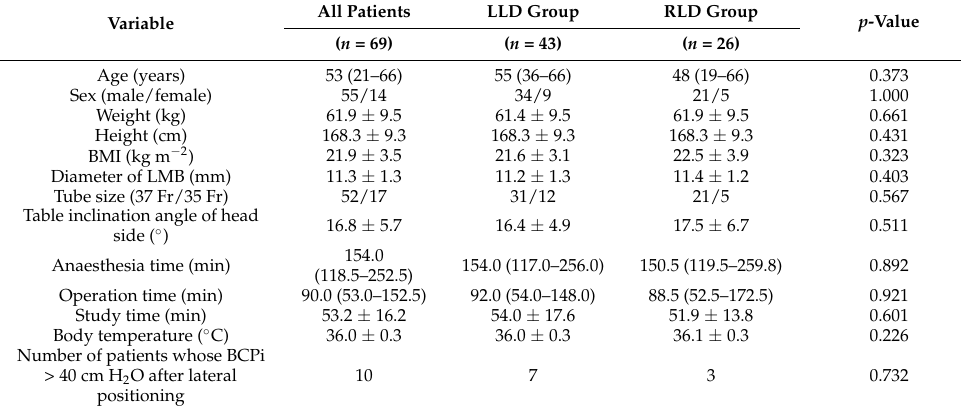
Table 1. Characteristics of patients before and during study period.